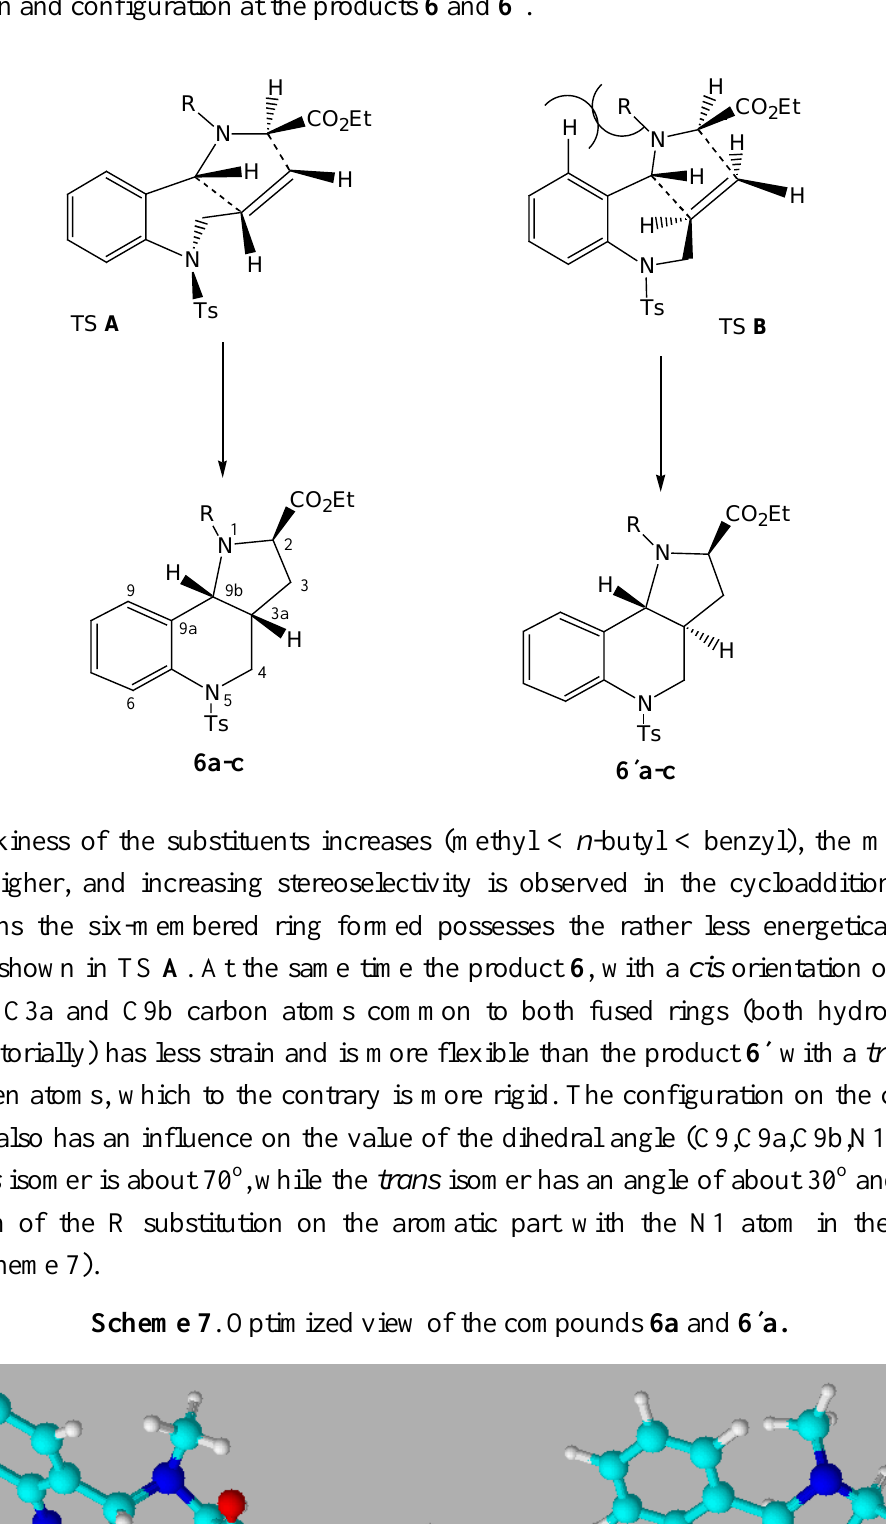
Scheme 6 . Schematic depiction of the transition states TS A and TS B during the reaction and configuration at the products 6 and 6´